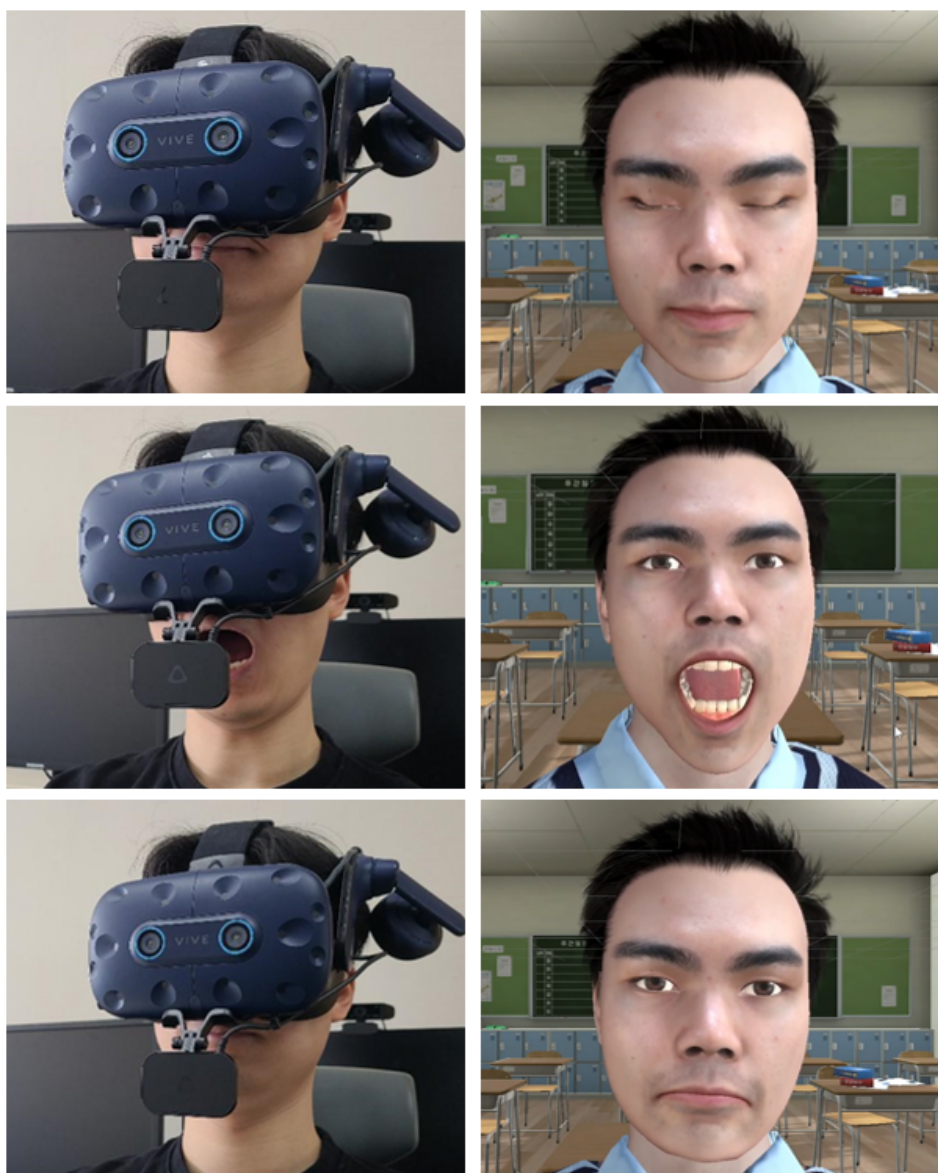
Figure 8. Results of facial